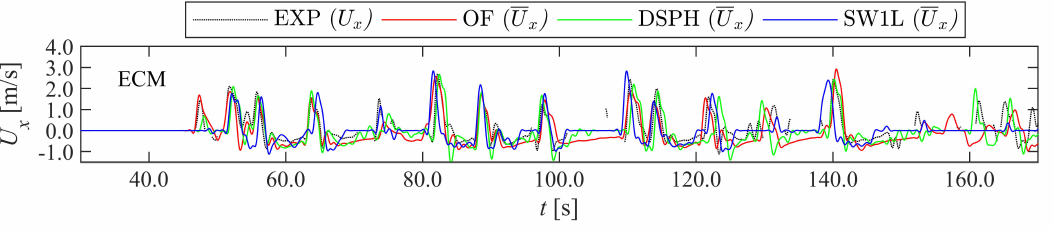
Figure 6. Comparison of the U x time series at the ECM location. The zero-reference is the promenade bottom. Adapted from the work in [3], with permission from the authors, 2020.